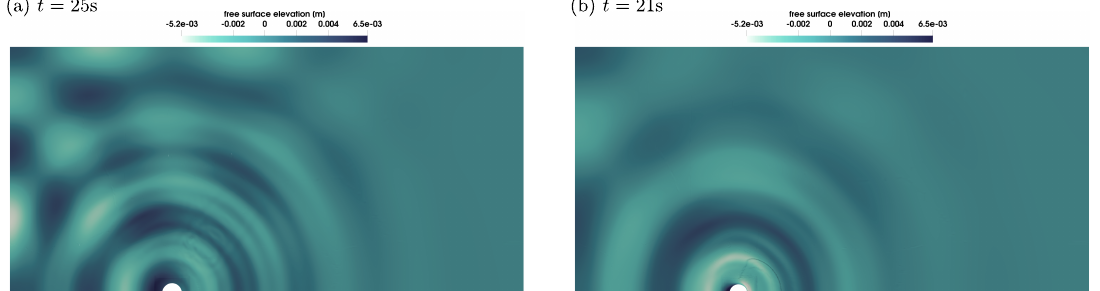
Figure 20. Screen shots of the free surface during the multi-frequency forced oscillation test at t = 25 s ( a ) t = 21 s ( b